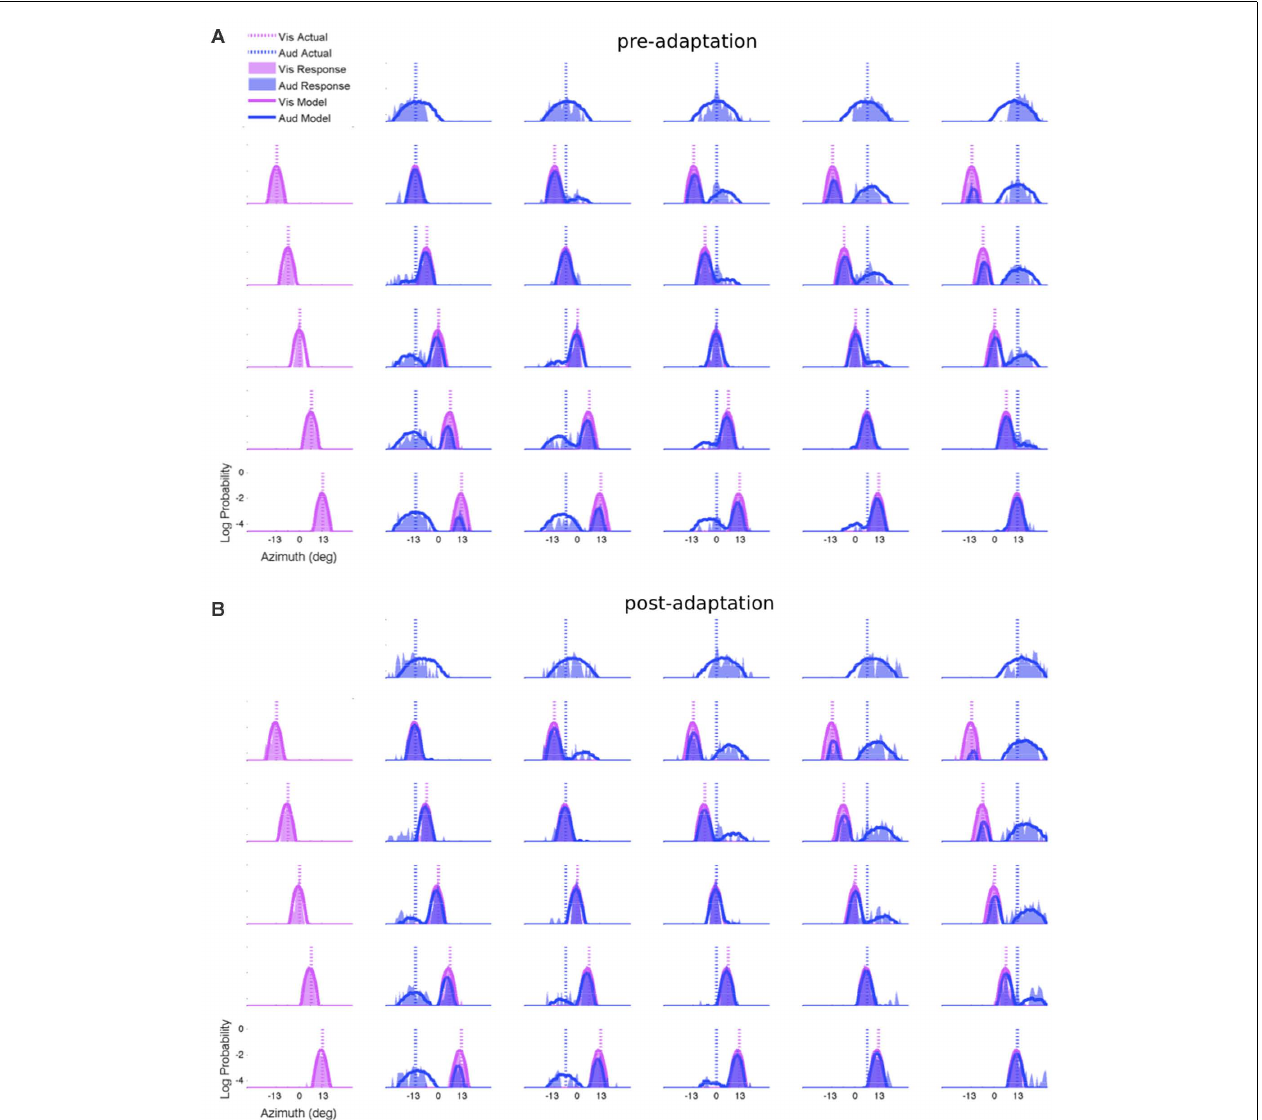
shown by the magenta vertical dotted lines.The remaining 25 panels in each figure show the bisensory conditions with both the visual and auditory response probabilities. (A) Pre-adaptation test data combined across 18 subjects who used the same decision-making strategy (probability matching). (B) Post-adaptation test data combined across subjects who were in the AV-adaptation group and used the same decision-making strategy (probability matching). For this group of eight subjects the unisensory auditory responses were shifted to the right after adaptation as can be seen in the first